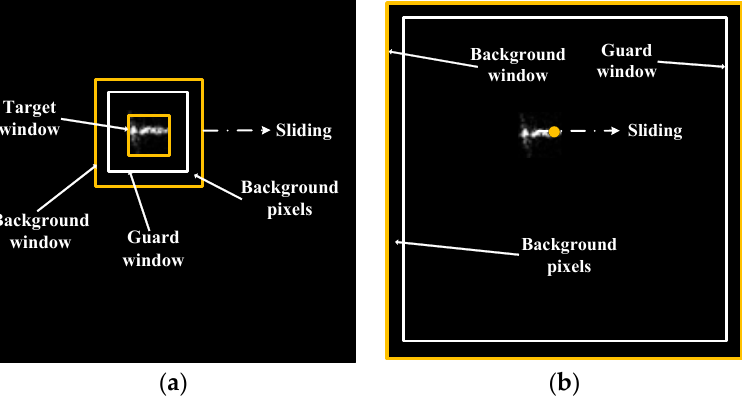
Figure 4. Comparison of sliding windows of low resolution CFAR (Constant False Alarm Rate) ( a ) and high resolution CFAR ( b ), the black block represents an image tile.